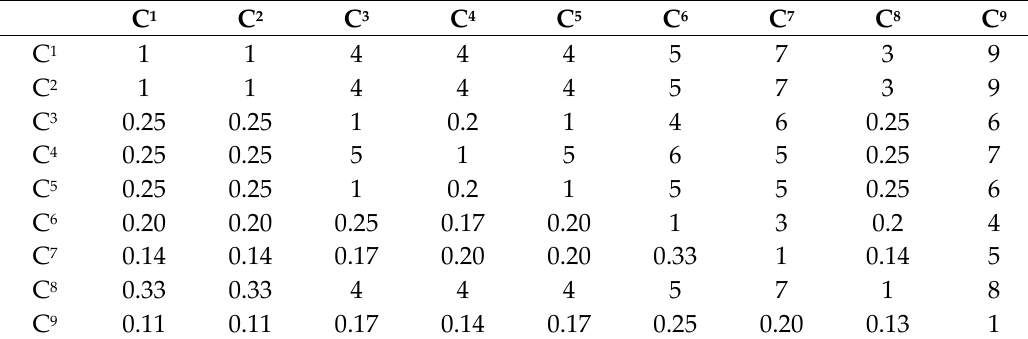
Table 4. Comparison matrix of the weights.